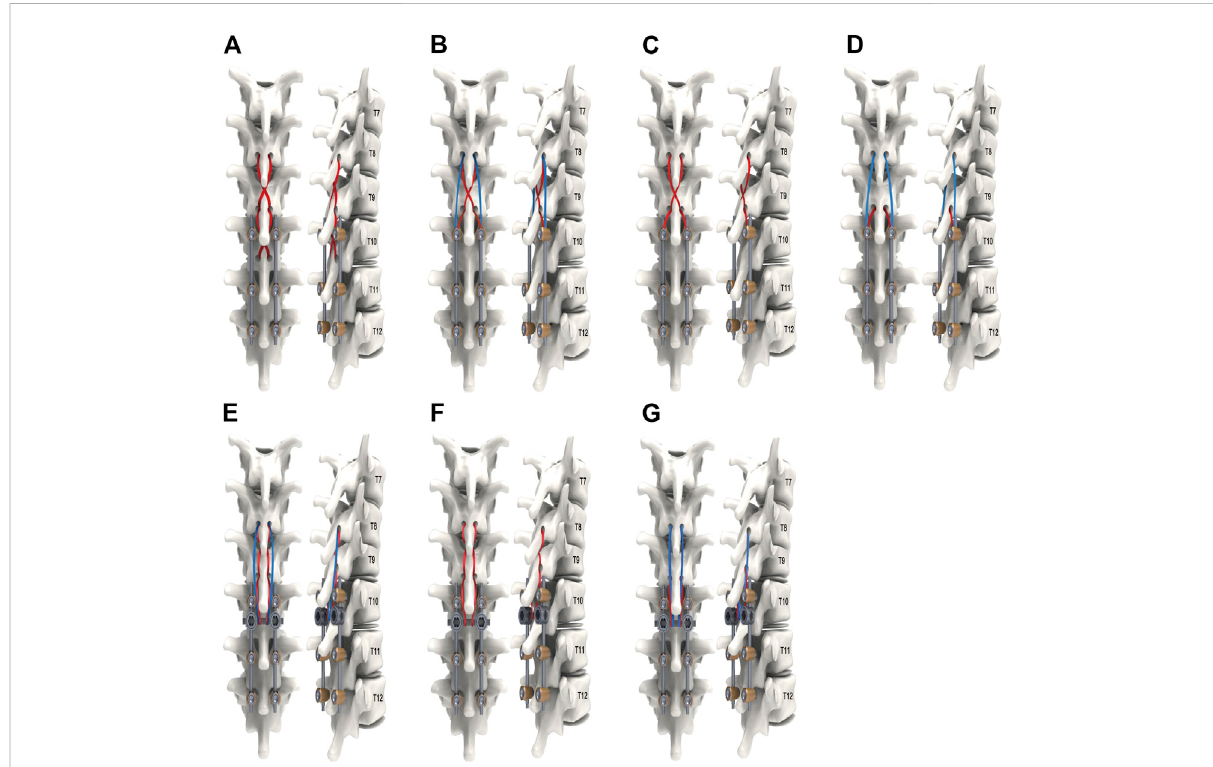
FIGURE 2 The remaining models, based on model IF with ligament augmentation con fi guration of common (CM), chained (CH), and common and chained (CHM) models; distally anchoredto thepediclescrew (PS), crosslink (CL),or thespinousprocess (SP): (A) Model SP-CH; (B) Model PS-CHM; (C) Model PS-CH; (D) Model PS-CM; (E) Model CL-CHM; (F) Model CL-CH; and (G) Model CL-CM.